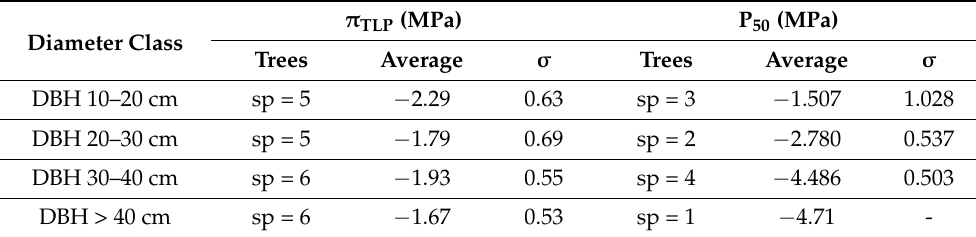
Table 3. π TLP and P 50 by diameter class, RJA